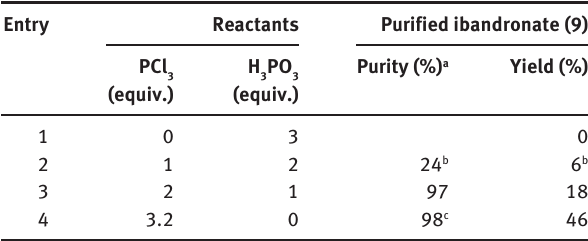
Table 3 Synthesis of ibandronate using the P -reactants in different ratios.